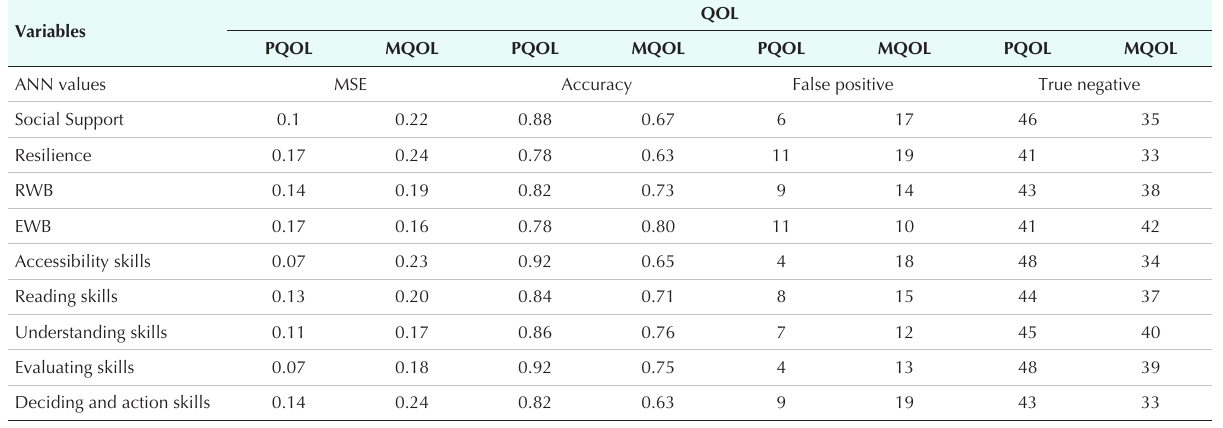
Table 2. Prediction of PQOL and MQOL based on 9 input variables of study (n = 260)